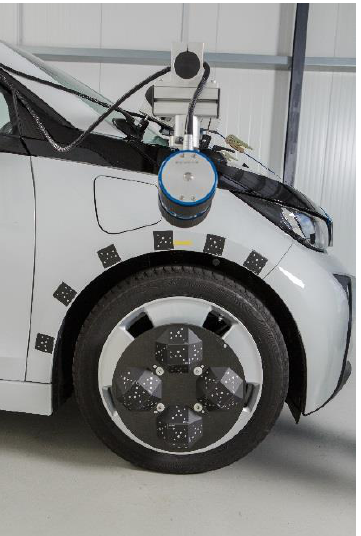
Figure 27: Test preparation: Camera, wheel adaptor and